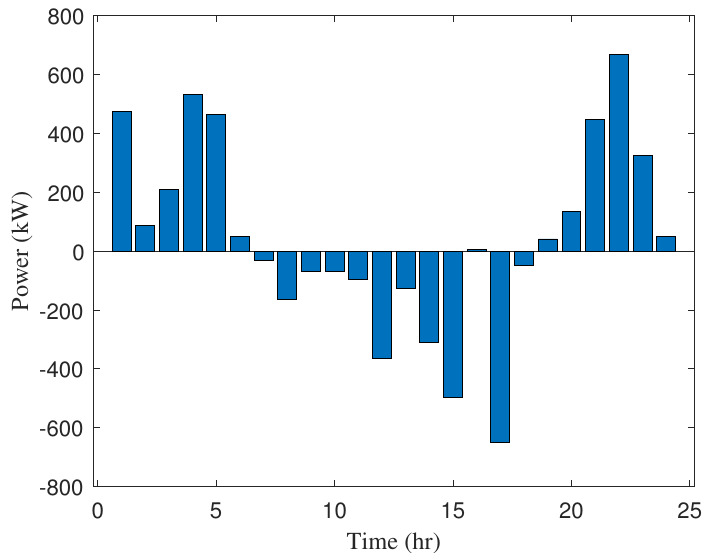
Figure 10. Optimal demand − response schedule considering peak load reduction.